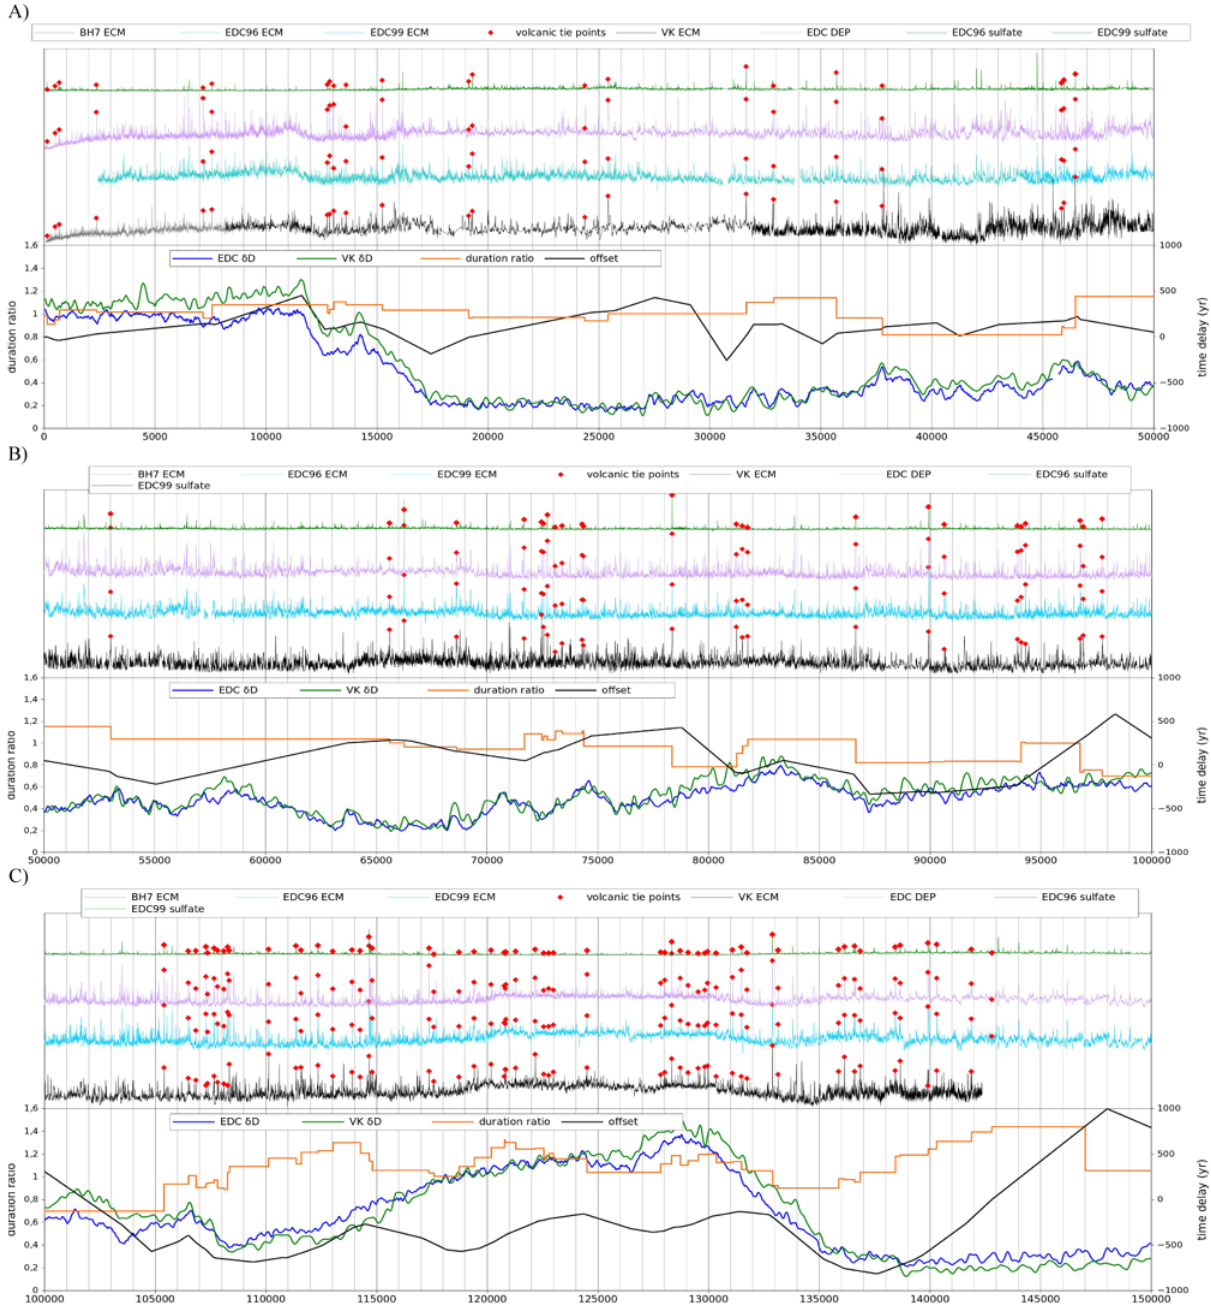
Fig. 6. EDC/VK volcanic synchronisation on the EDC3 age scale. (A) 0–50kyrBP; (B) 50–100kyrBP; (C) 100–150kyrBP. For (A) , (B) , (C) : Top) Black: ECM record from the VK-5G ice core. Grey: ECM record from the VK-BH7 ice core. Blue: ECM record from the EDC96 and EDC99 ice core. Purple: DEP record from the EDC99 ice core. Green: sulfate records from the EDC96 and EDC99 ice cores. Red dia- monds: volcanic tie points. For simplicity, y-axes are not plotted. Bottom) Blue: Deuterium record from the EDC ice core. Green: Deuterium record from the Vostok ice core. The deuterium records have been resampled every 20yr and an 11-point moving average was applied. Orange: ratio of the duration between two tie points in VK-FGT1 (Parrenin et al., 2004) and EDC3 (Parrenin et al., 2007b). Black: time delay between the VK-3G and EDC deuterium records after volcanic synchronisation. For simplicity, y-axes for the deuterium records are not